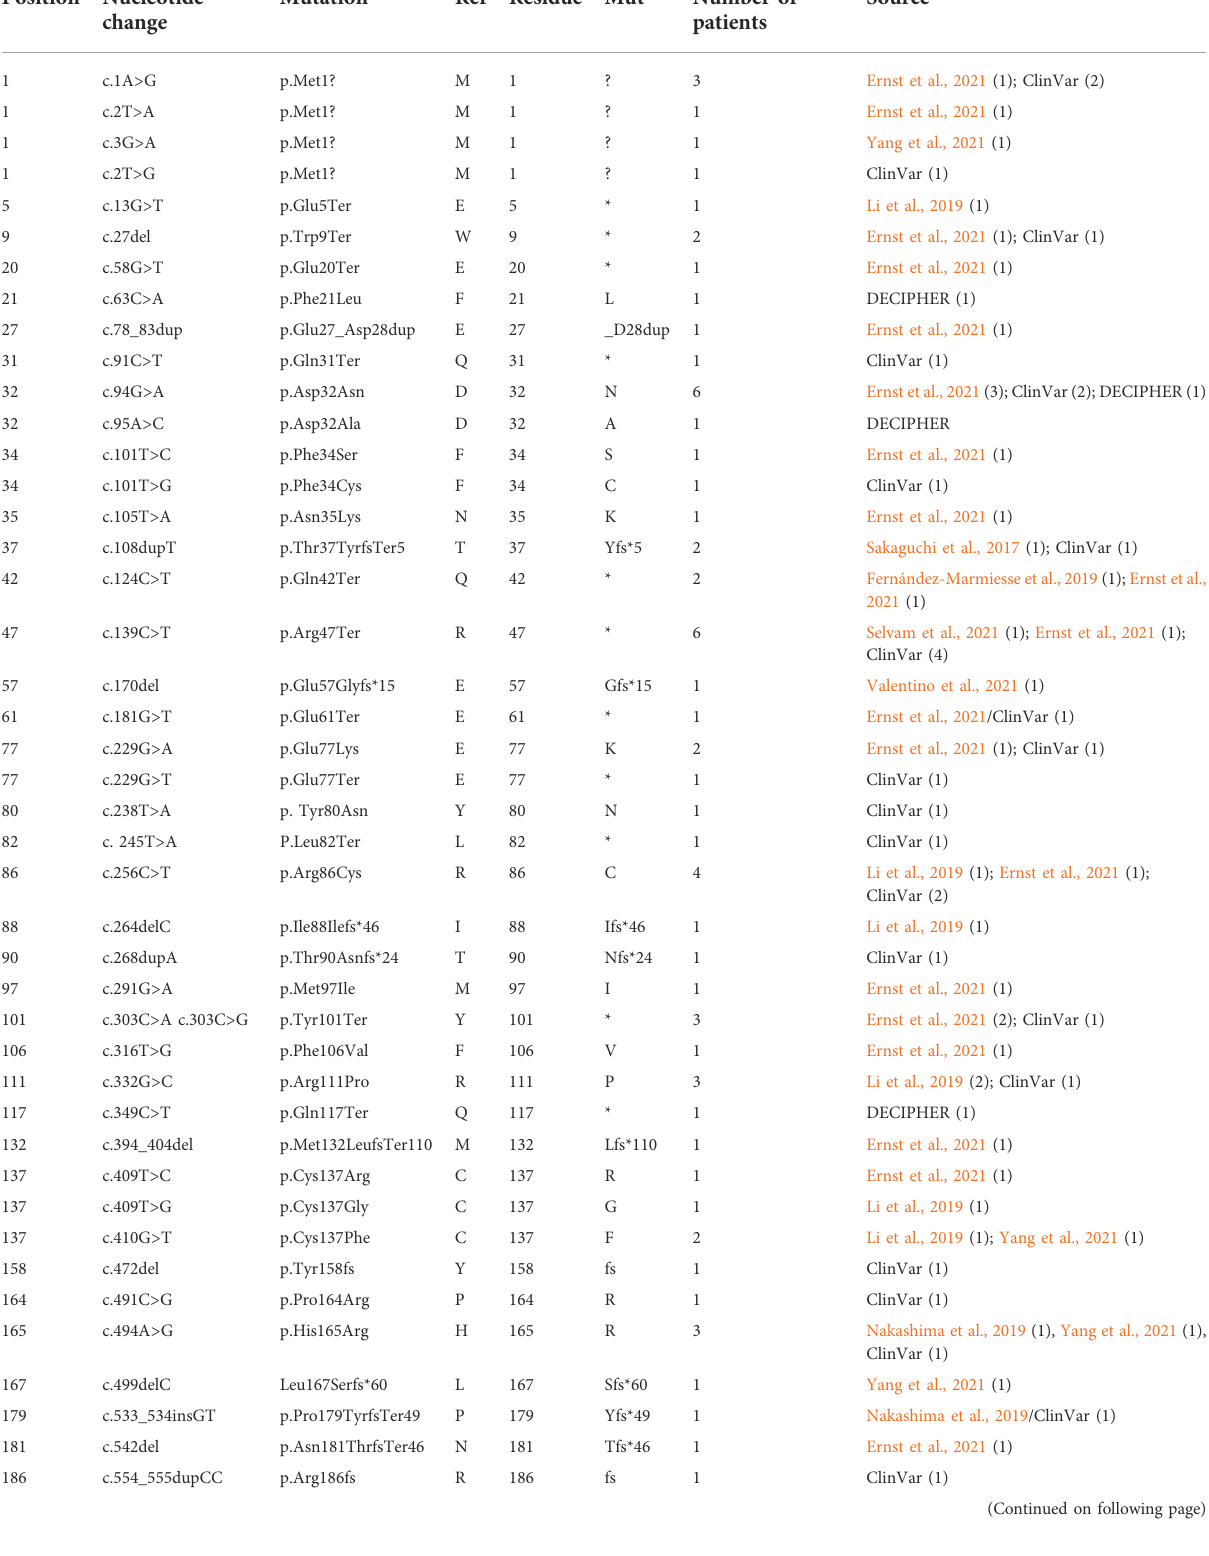
TABLE 2 CK2 β mutants associated with POBINDS phenotypes. Table includes nucleotide and amino acid residue changes, number of patients per mutation and reference/source. (A) includes variants that affect amino acid residues and (B) includes splice variants. Total number of patients for CK2 α was 90. For samples found in different sets, we included all sources separated with a “ / ”